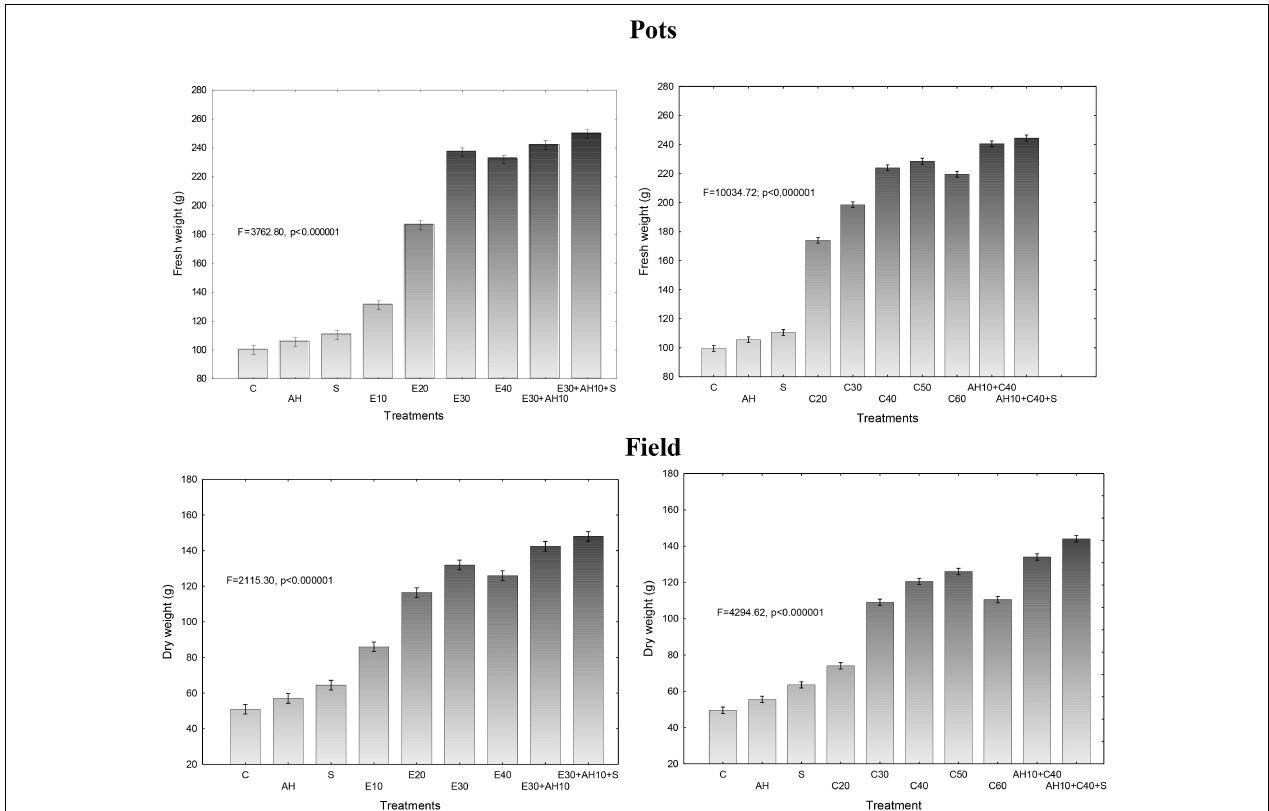
FIGURE 4 | Final fresh and dry weight of one sorghum plant cultivated in field and fertilized with liquid waste from a biomass biodigestion to methane, non-centrifuged (E 10–40 m 3 ha − 1 ) and centrifuged (C 20–60 m 3 ha − 1 ), Apol-humus (AH; 10 L ha − 1 ) and Stymjod (S; 5 L ha − 1